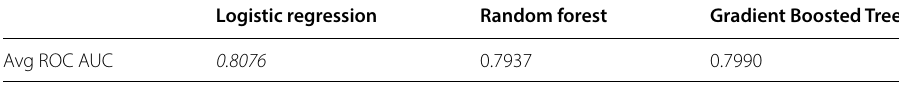
Italic font indicates the maximum ROC AUC score